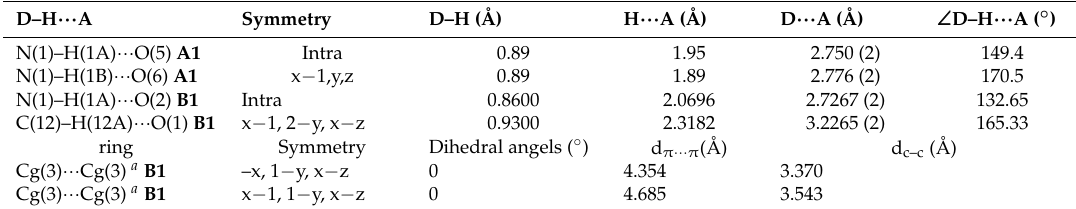
Table 3. Intra- and intermolecular distances and π ··· π interactions of A1 and B1 .